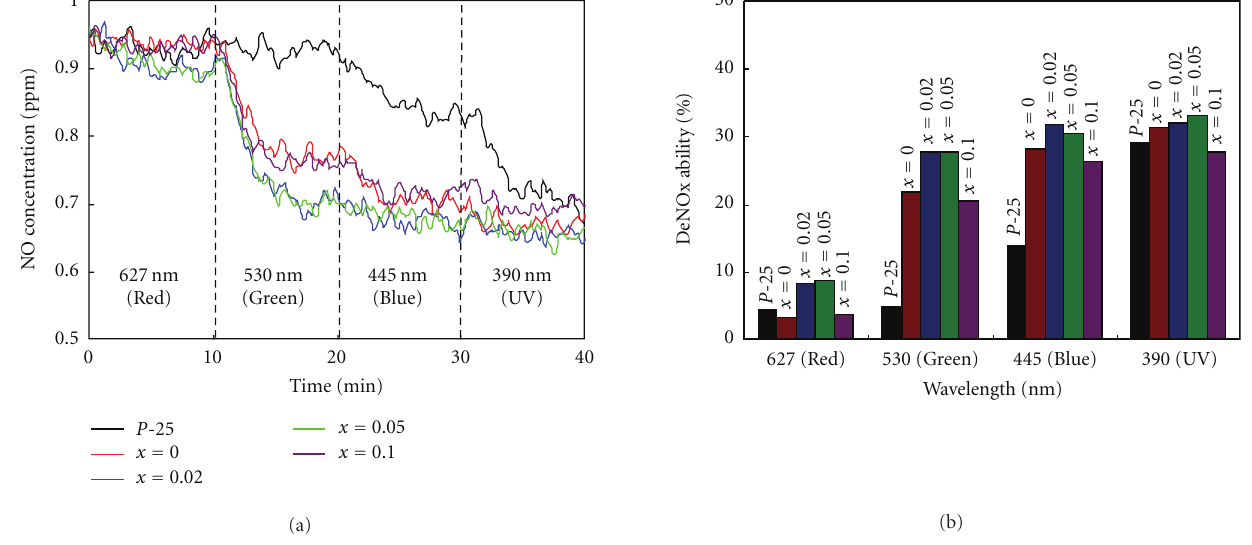
Figure 9: Photocatalytic activity of SrTi 1 − x Ta x O 3 − y N y